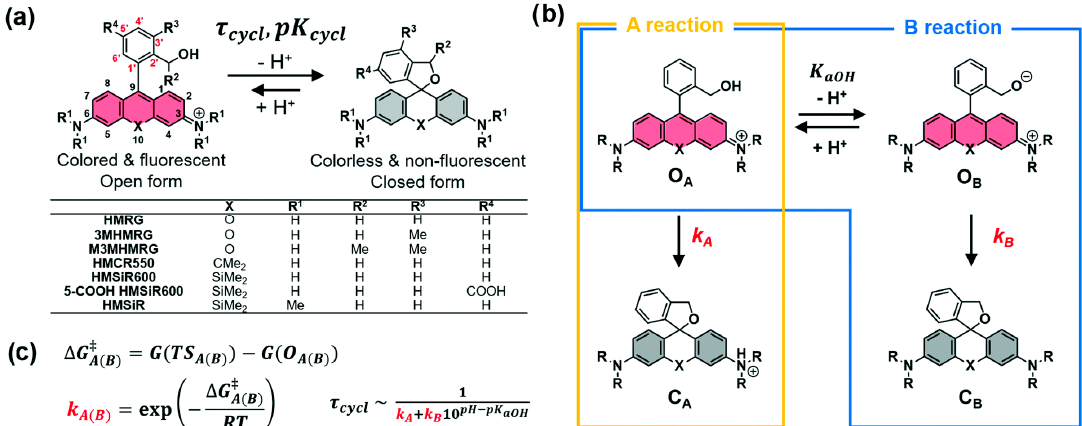
Figure 30. Computational approach to predict blinking properties of spirocyclic dyes: ( a ) Thermal equilibrium of HMR derivatives based on intramolecular spirocyclization between the fluorescent open form and the non-fluorescent closed form. τ cycl is the lifetime of the open form. pK cycl is the equilibrium constant of intramolecular spirocyclization; ( b ) Model mechanism of ring-closing reaction of HMR derivatives; ( c ) Formula for τ cycl based on statistical mechanics and transition-state theory. Adapted with permission from [45]. Table 3. Photophysical properties of spontaneously blinking fluorophores with calculated and experimental values.